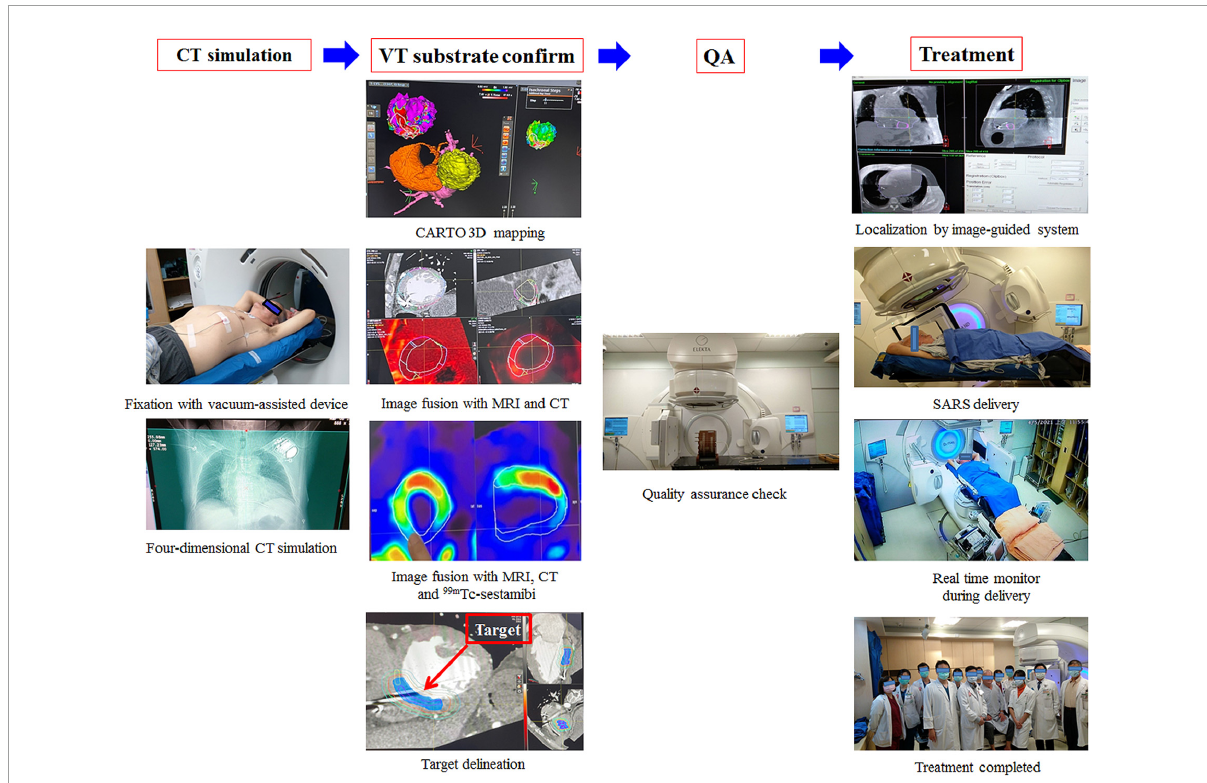
FIGURE3 Multimodal imaging combined with scar imaging, including the CARTO mapping system (Biosense, Diamond Bar, CA), CT, MRI and 99 m Tc-sestamibi MPI, was used offline to delineate a target for ablation. A plan was developed in the Pinnacle3 planning system (version 9.8.1, Philips Medical Systems, Madison, WI, USA). One day before treatment, quality assurance was performed. On the day of treatment, the patient was immobilized on the vacuum device, and cone-beam computed tomography (CBCT) was used for patient setup and target localization. The treatment unit was aligned with the patient, and a dose of 12 Gy was delivered precisely by volumetric-modulated arc therapy (VMAT) through a linear accelerator machine (Versa HDTM, Elekta, Crawley, West Sussex, UK) with 6 MV photons.